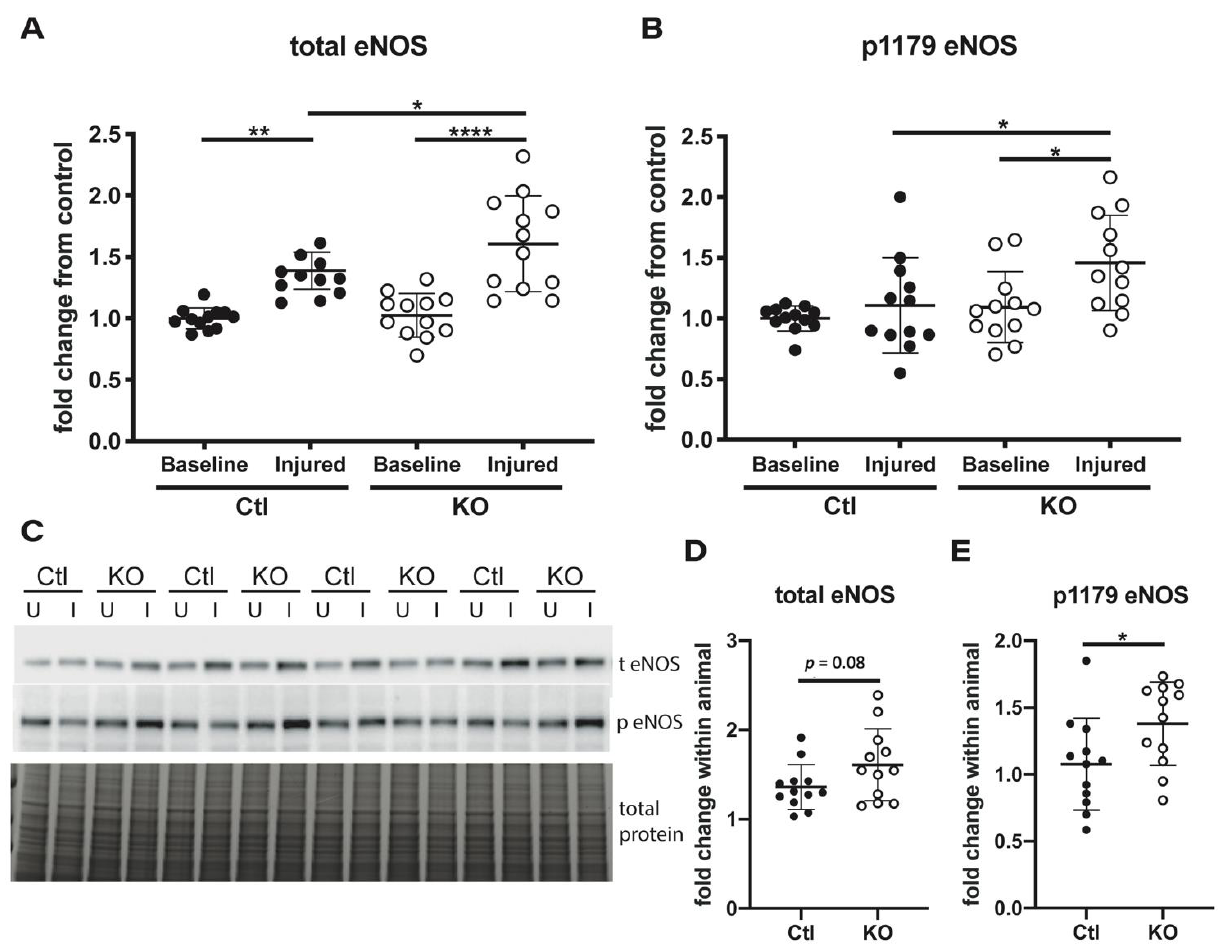
Figure 5. eNOS Phosphorylation at Ser1179 is increased in injured kidneys of endothelial γ ENaC knockout mice. Whole kidney lysates from uninjured (U) and injured (I) kidneys from control and knockout mice were assessed by SDS-page electrophoresis for levels of total eNOS and phosphorylated eNOS (p1179 eNOS). ( A ) Total eNOS was quantified and compared to levels in uninjured, control kidneys and expressed as fold-change from uninjured, control kidneys. ( B ) The same kidneys were examined for phosphorylation at Ser1179 ( C ) Representative blots for both total and phosphorylated eNOS are shown with total protein for normalization. The change in expression levels between the uninjured and injured kidney from each animal was calculated as a fold change for both total ( D ) and phosphorylated ( E ) eNOS. n = 12 to 16 for each measure; data presented as mean ± SD; unpaired t -tests or one-way ANOVA with multiple comparisons performed to determine significant differences with * < 0.05, ** < 0.005, **** < 0.00005 .